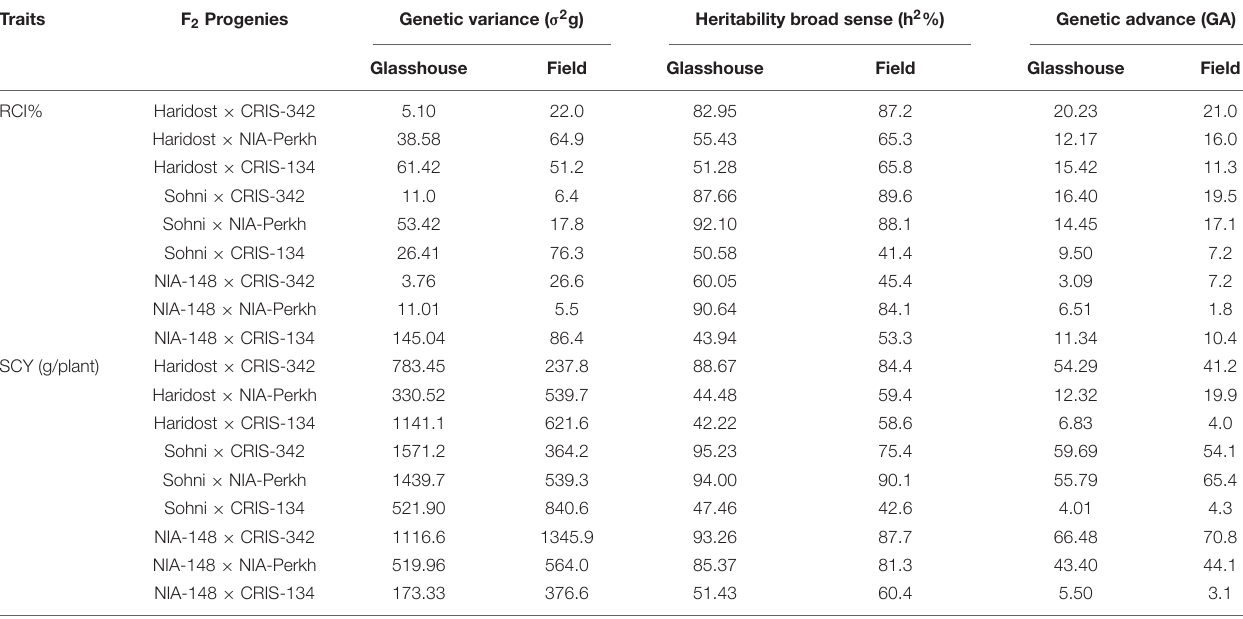
TABLE 7 | Genetic studies of RCI% and SCY (g/plant) in F 2 progenies. Traits F 2 Progenies Genetic variance ( σ 2 g) Heritability broad sense (h 2 %) Genetic advance